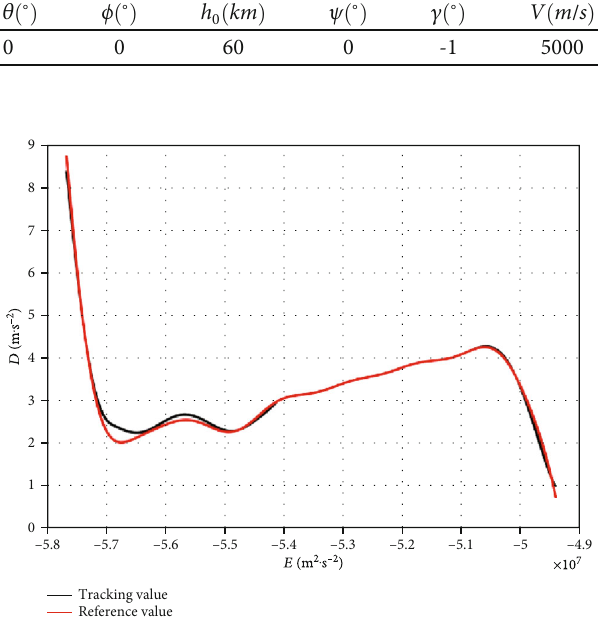
Figure 14: Minimum drag acceleration pro fi le tracking ability.